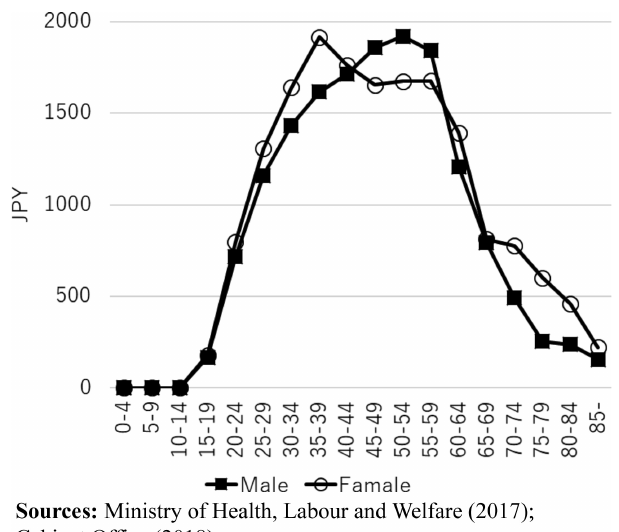
Figure 5. The labor value of Japanese people by gender age